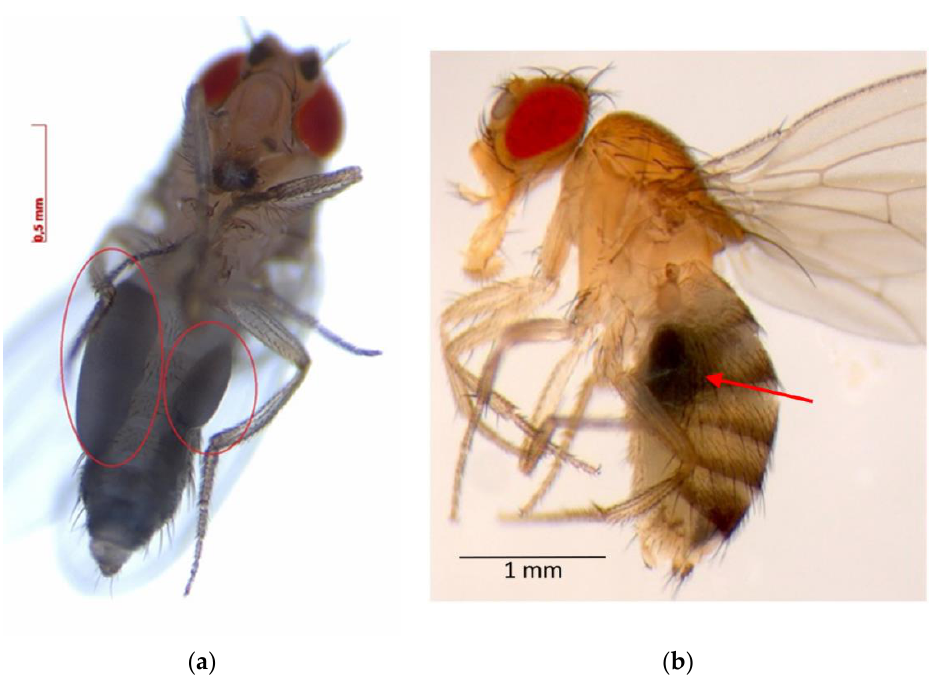
Figure 6. Iron bioaccumulation: Fe 3 O 4 NPs in the abdominal region of flies as observed with a stereomicroscope ( a ) ventral view and ( b ) lateral view. Table 3. Bioaccumulated iron in Drosophila melanogaster exposed to non-coated and chitosan- coated magnetite nanoparticles. All concentrations were corrected with blank measurements.